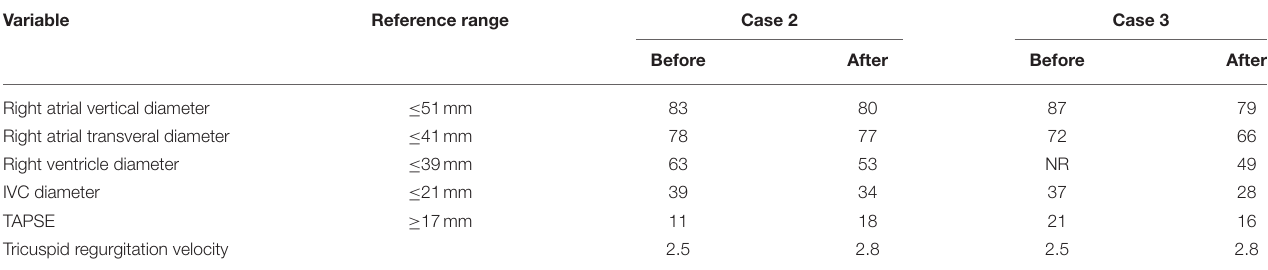
TABLE 4 | Echocardiography of Case 2 and 3 before and after coil embolization.